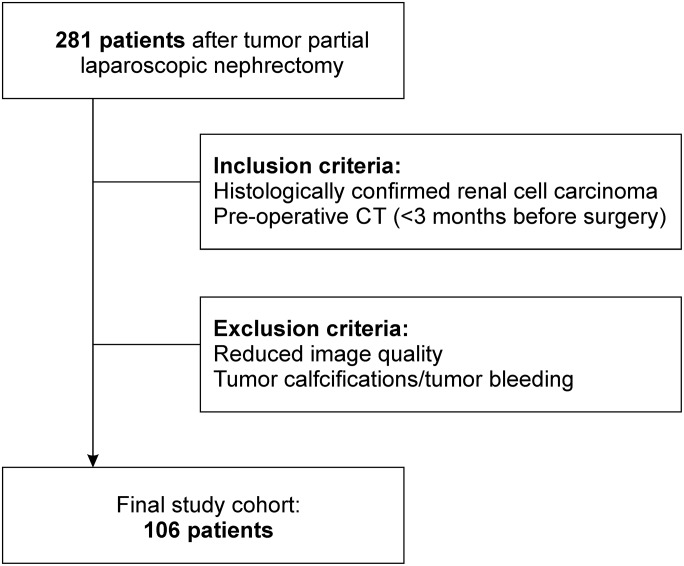
Flow chart of the patient selection.